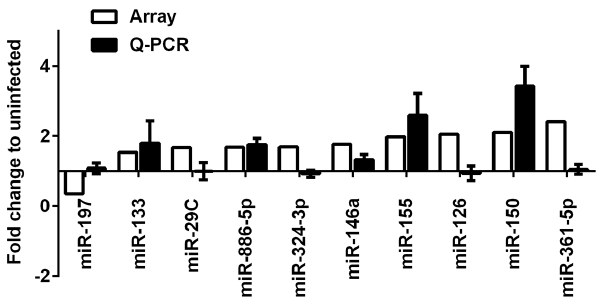
Figure 1. Validation of the TLDA results by qRT-PCR analysis. The relative abundance of differentially expressed microRNAs was determined using individual Taqman microRNA assays, and results were normalized to the internal control RNU48. Data shown are the mean 6 SEM from four independent experiments.